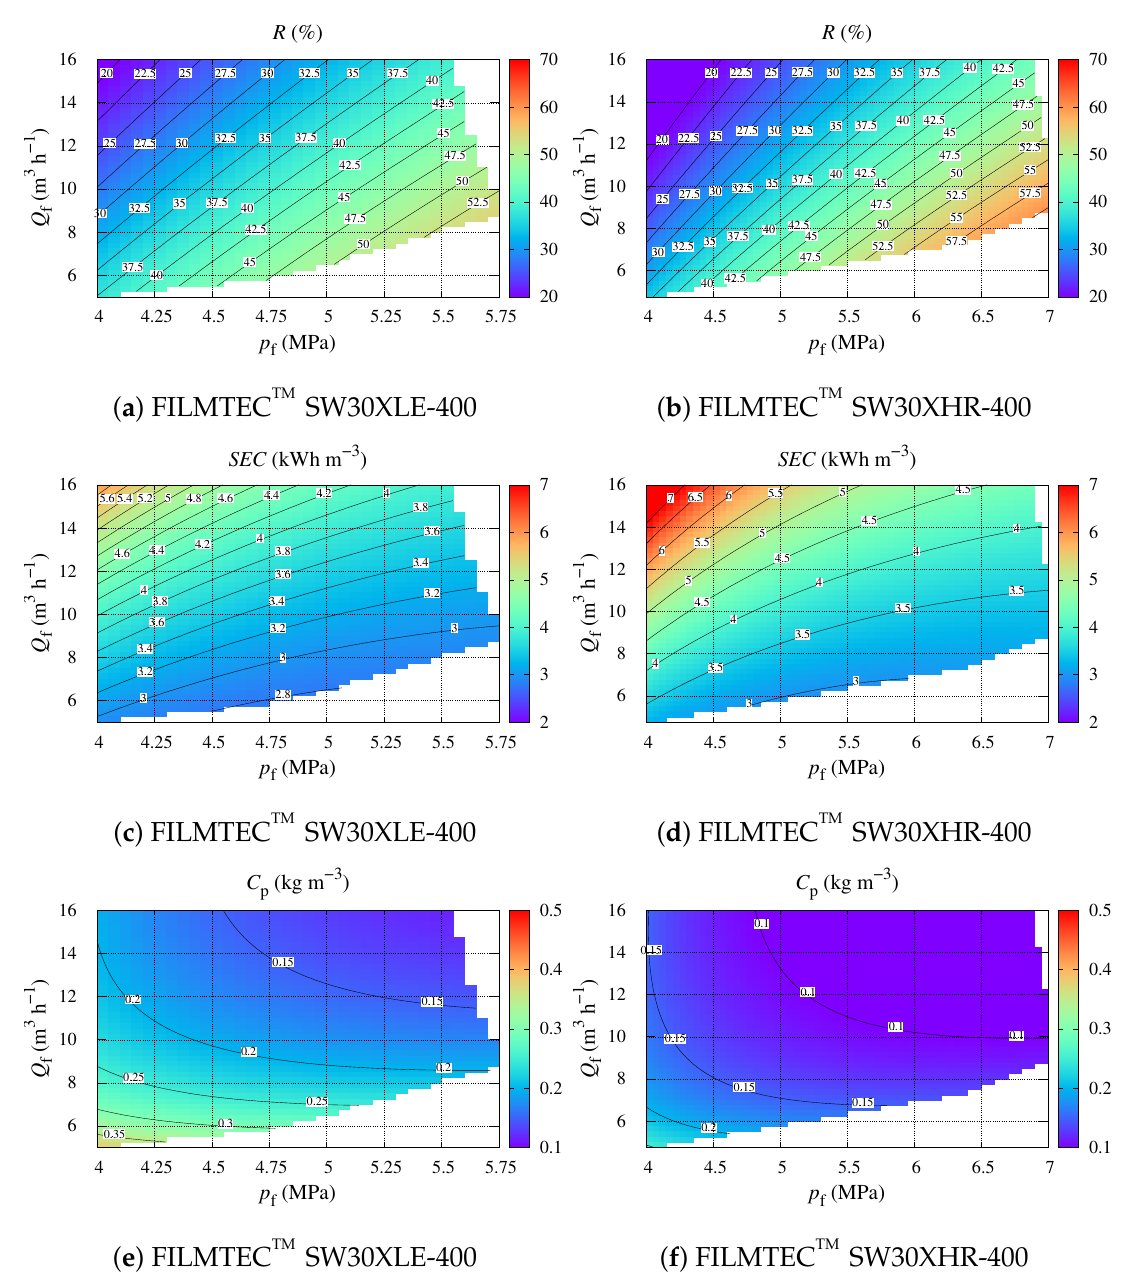
Figure 2. R , SEC and C p of the two studied membranes with different permeability coefficients, PV with 7 SWMMs, C f = 32 kg m − 3 , L / d = 6 and β = 90 ◦